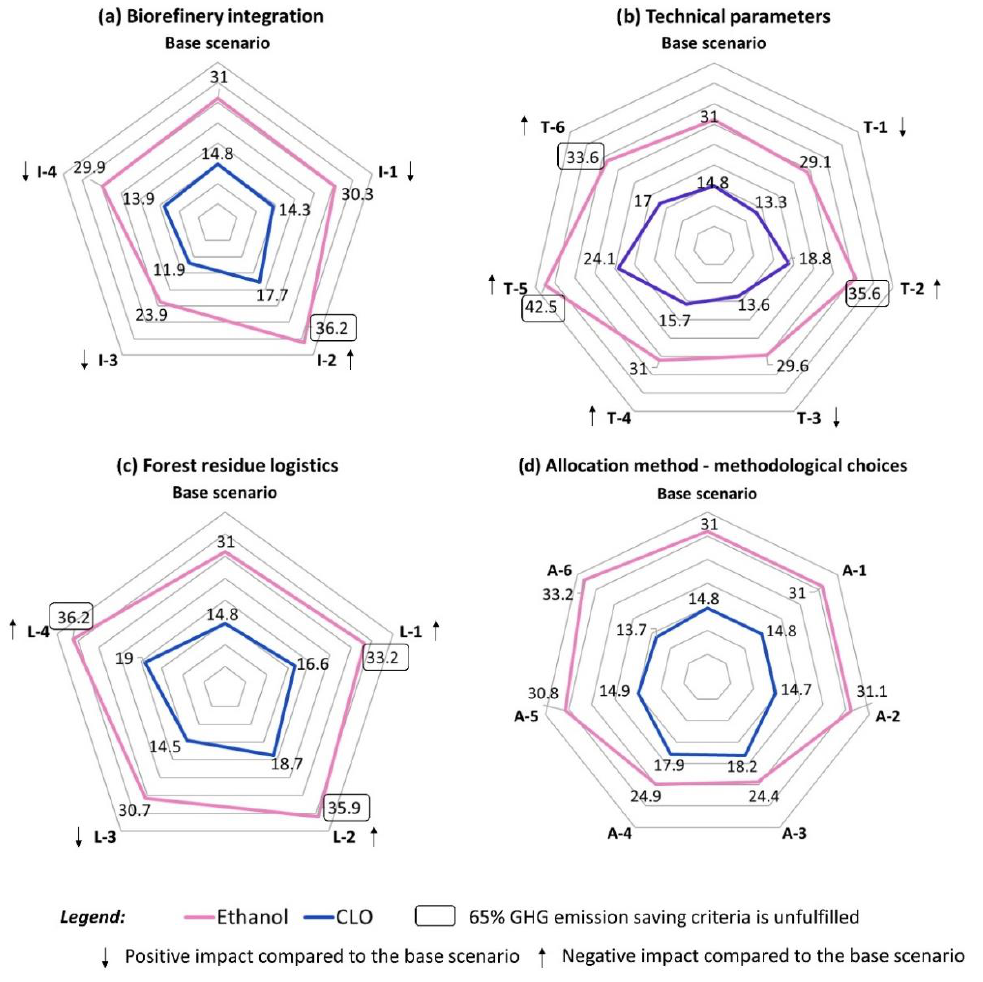
Figure 7. GWP results - single point sensitivity analysis.